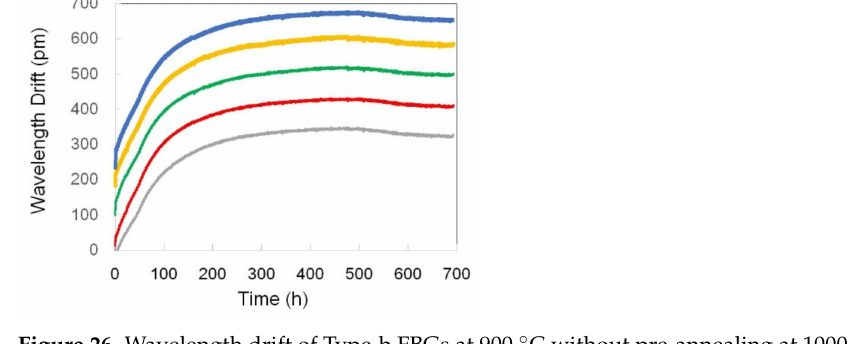
Figure 26. Wavelength drift of Type-b FBGs at 900 ◦ C without pre-annealing at 1000 ◦ C.